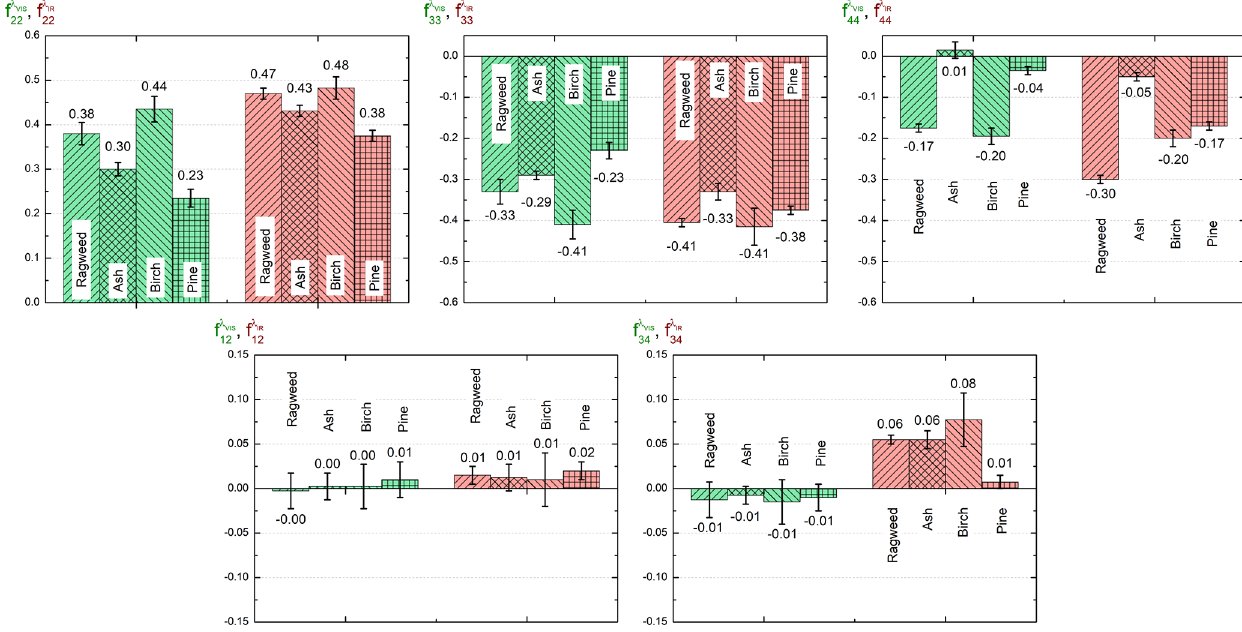
Figure 5. Retrieved scattering matrix elements of ragweed, ash, birch and pine at a 177.5 ◦ scattering angle at wavelengths λ VIS and λ IR , with corresponding uncertainties evaluated by applying the methodology presented in Sect. 3. For each pollen taxon, the evaluation of the scattering matrix has been repeated with different samples: each evaluated scattering matrix lies within presented error bars. Table 1. Retrieved scattering matrix elements of ragweed, ash, birch and pine at a 177.5 ◦ scattering angle at wavelength λ VIS .